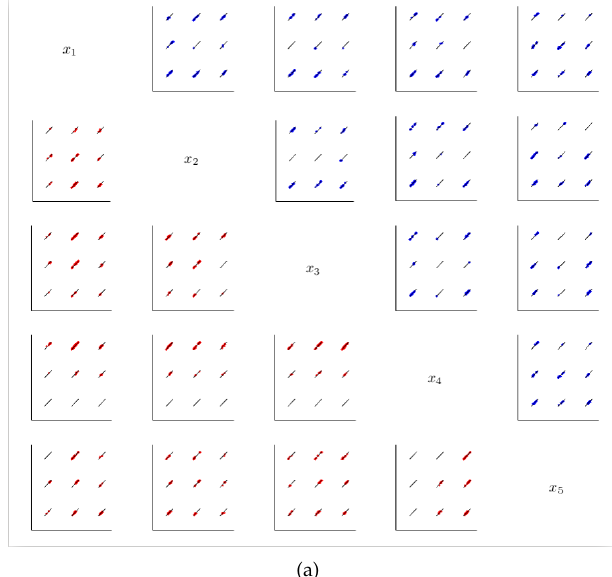
Figure 4. Graphical results of the run with the median values for the OMNI1 function for NSGA-II. ( a ) Objective Space Original; ( b ) Objective Space VR; ( c ) Decision Space, pairwise plot of each variable. The left-down and red marks correspond to the original algorithm, while the right-up and blue ones are the VR version.